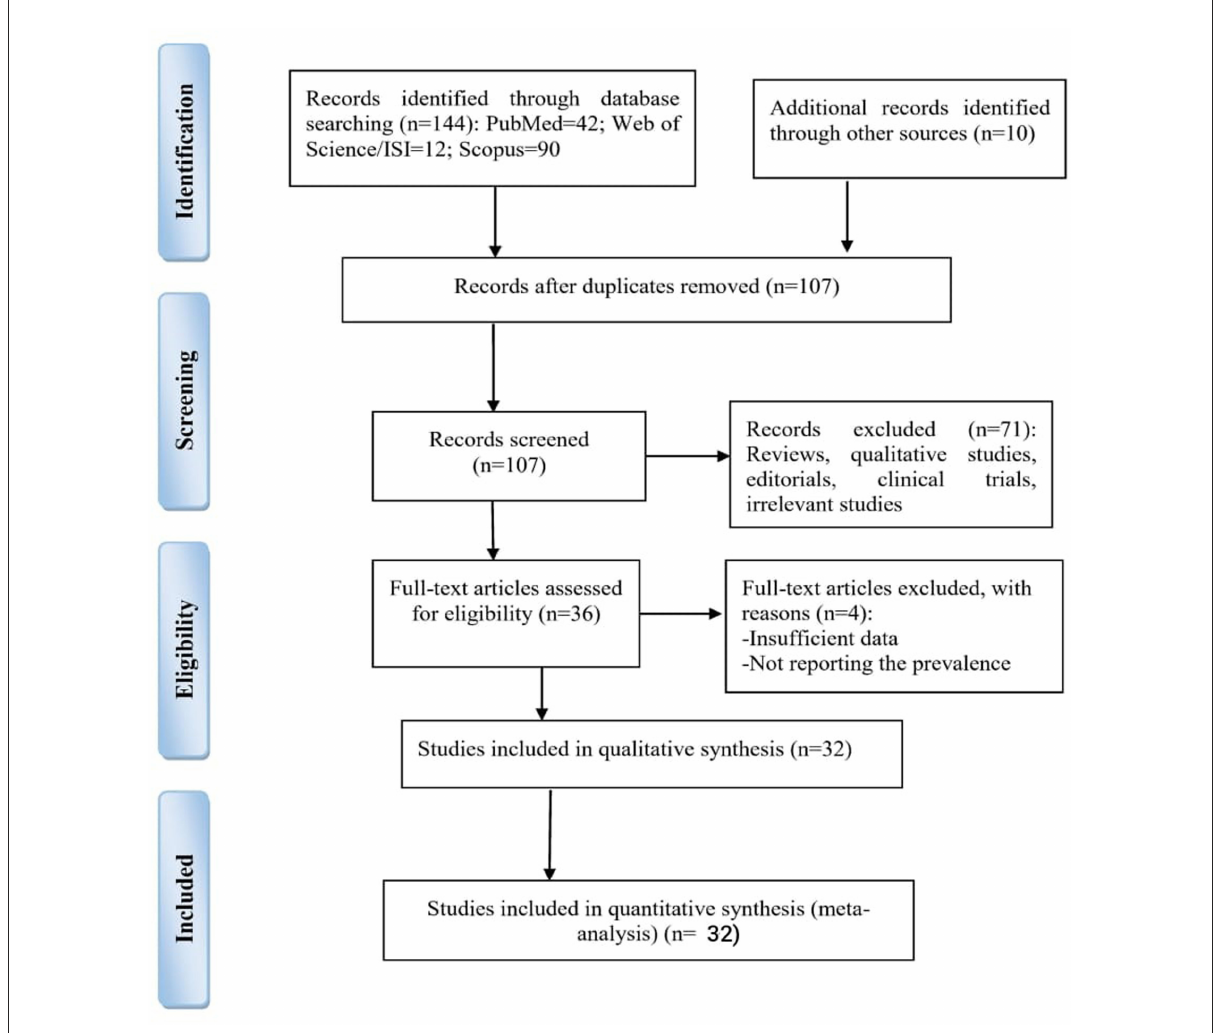
FIGURE1 Flow diagram of the search and screening processes based on PRISMA